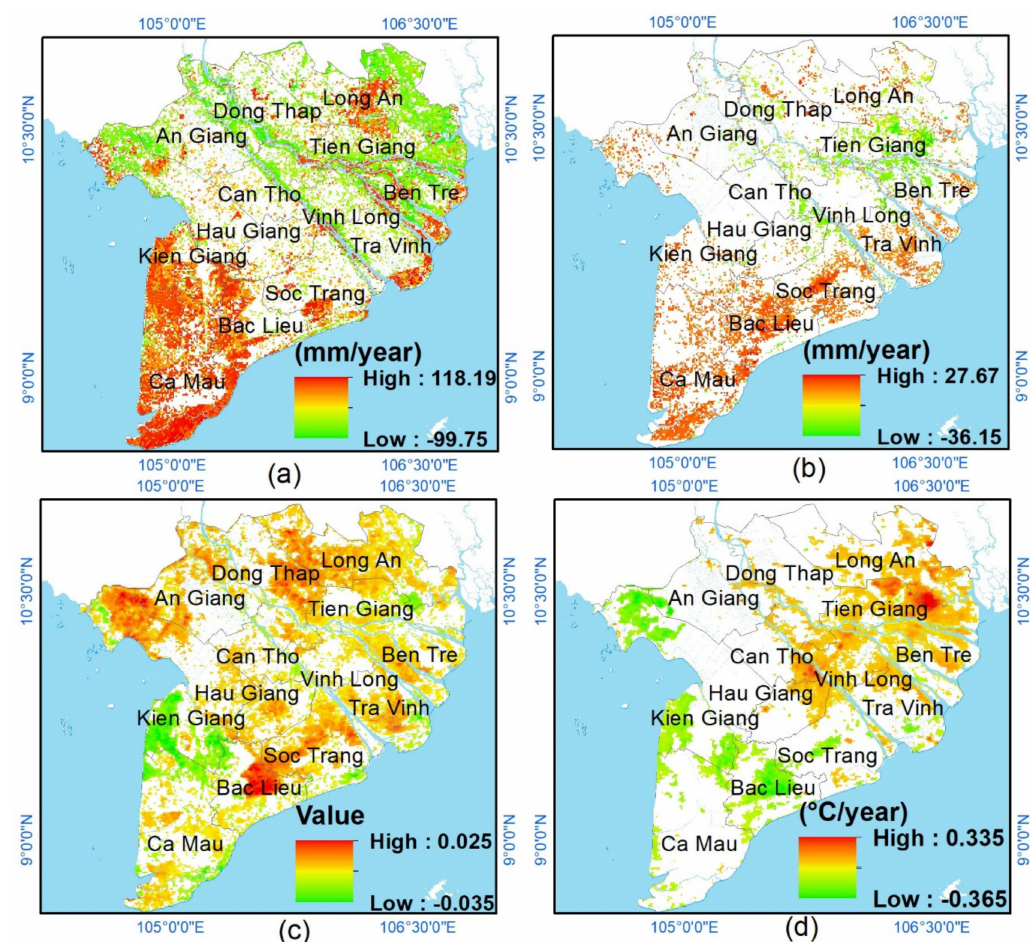
Figure 5. Spatiotemporal changes in ( a ) ET (mm / year), ( b ) PET (mm / year), ( c ) EVI, and ( d ) LST ( ◦ C / year) in MRD ( p <